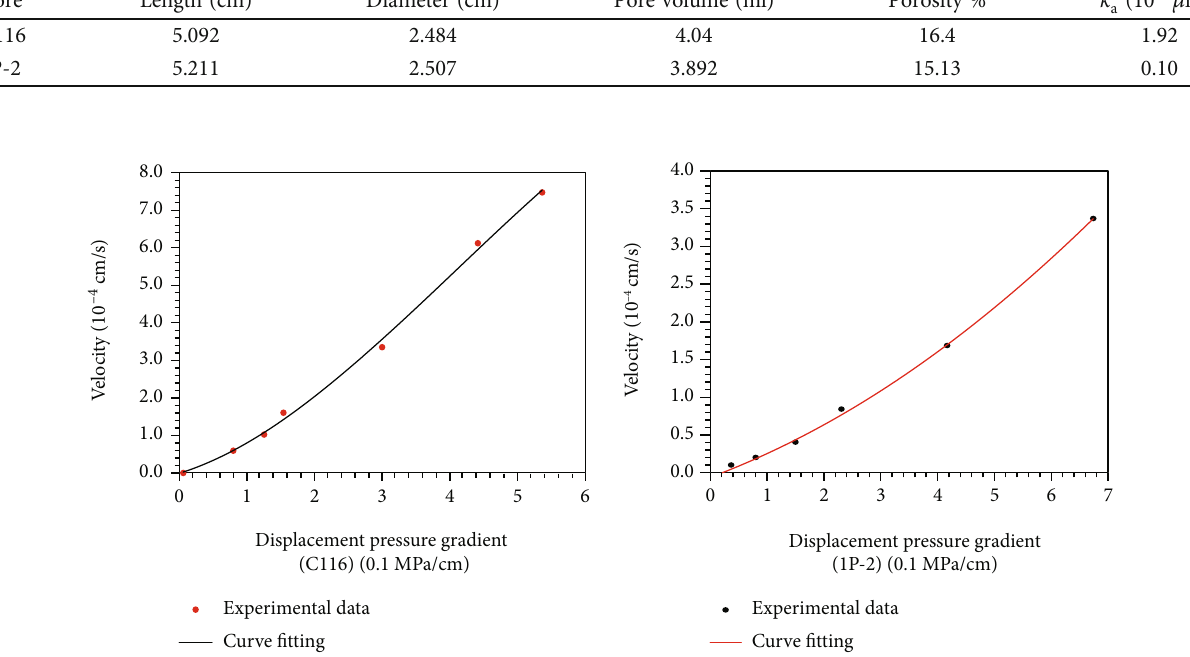
Figure 2: Nonlinear fl ow curve under bound irreducible water